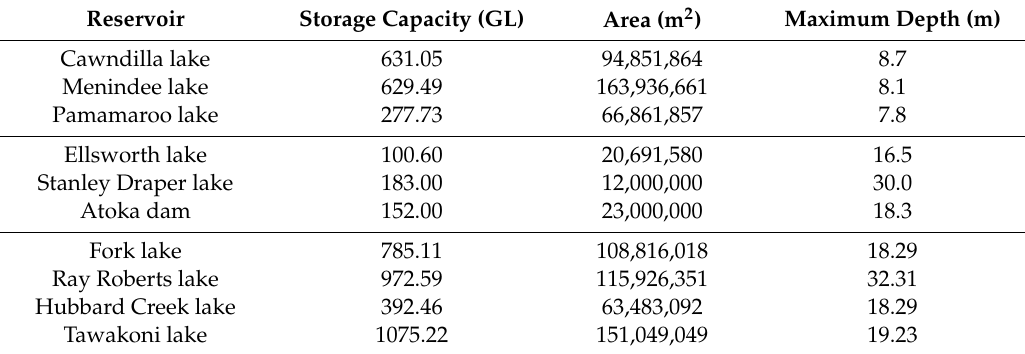
Figure 6. Terrain elevation of Texas lakes. Table 1. Design characteristics of the studied reservoirs [30–33,35].